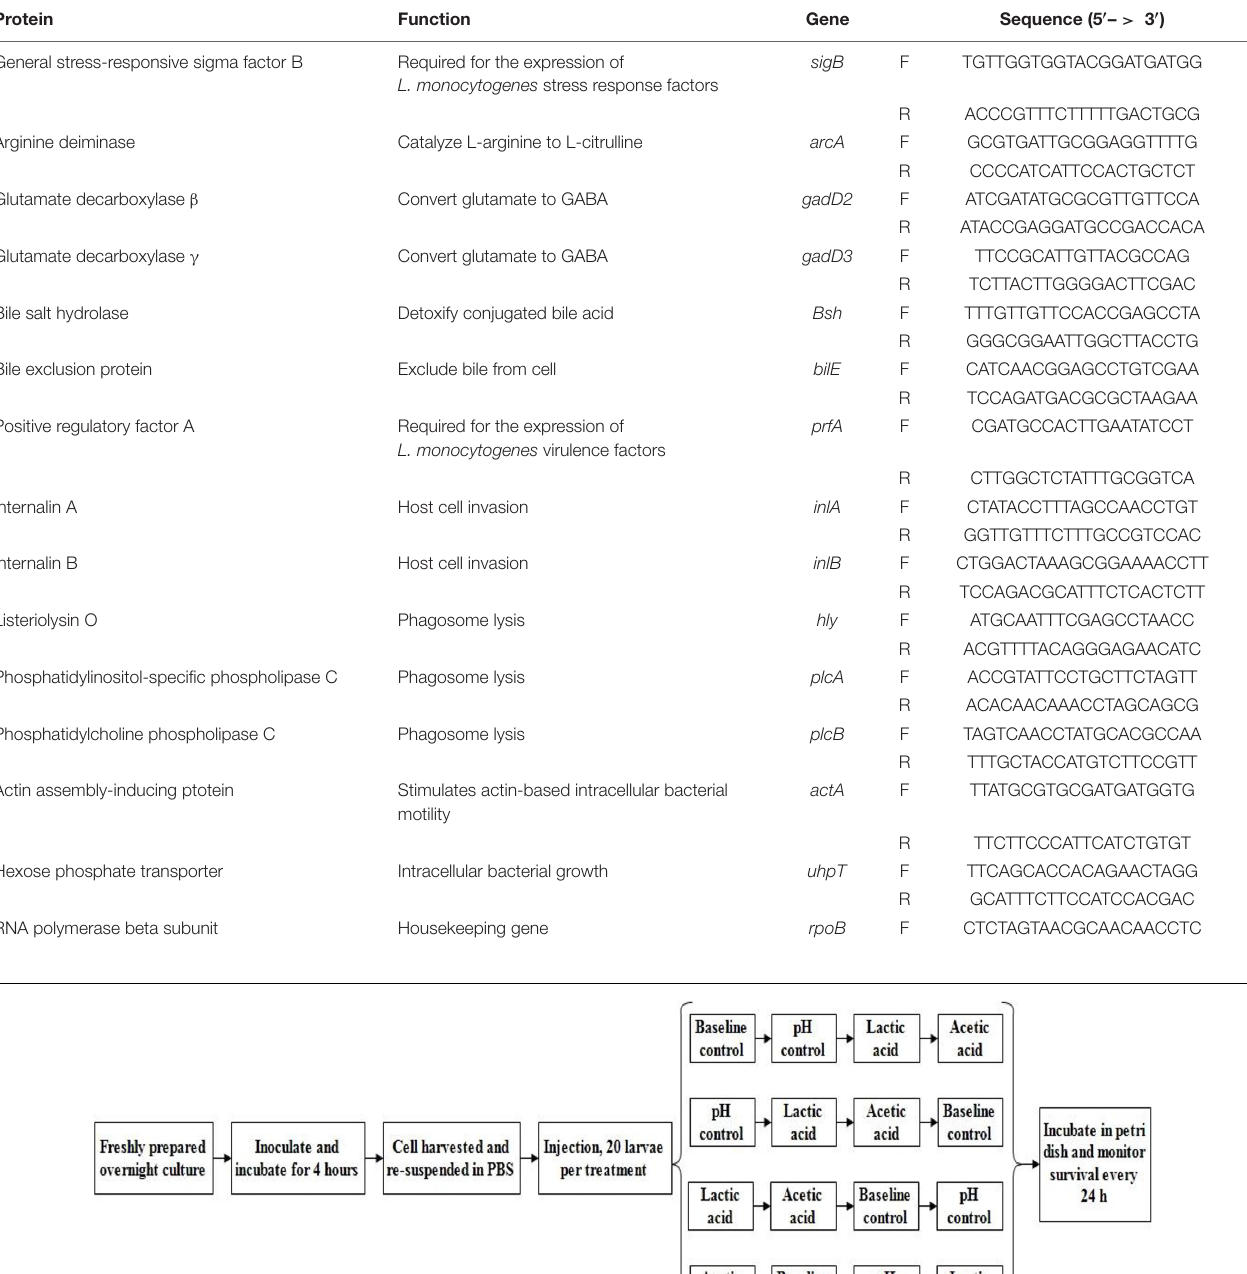
TABLE 2 | Primers used in this study.